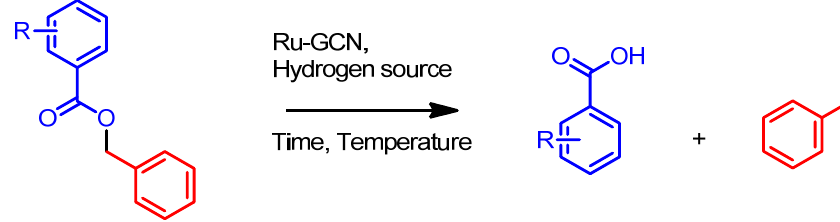
Scheme 1. Representative reaction of Ru ‐ GCN catalyzed hydrodebenzylation reaction.